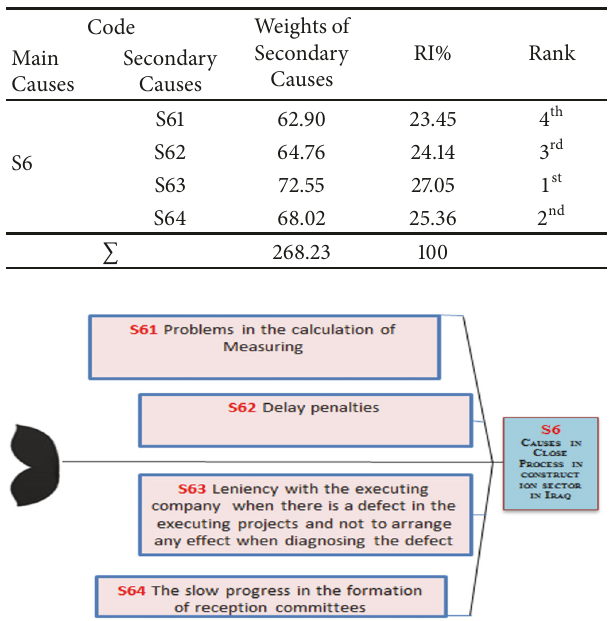
Table 9: Main causes weights, relative importance, and rank for project close management process group.